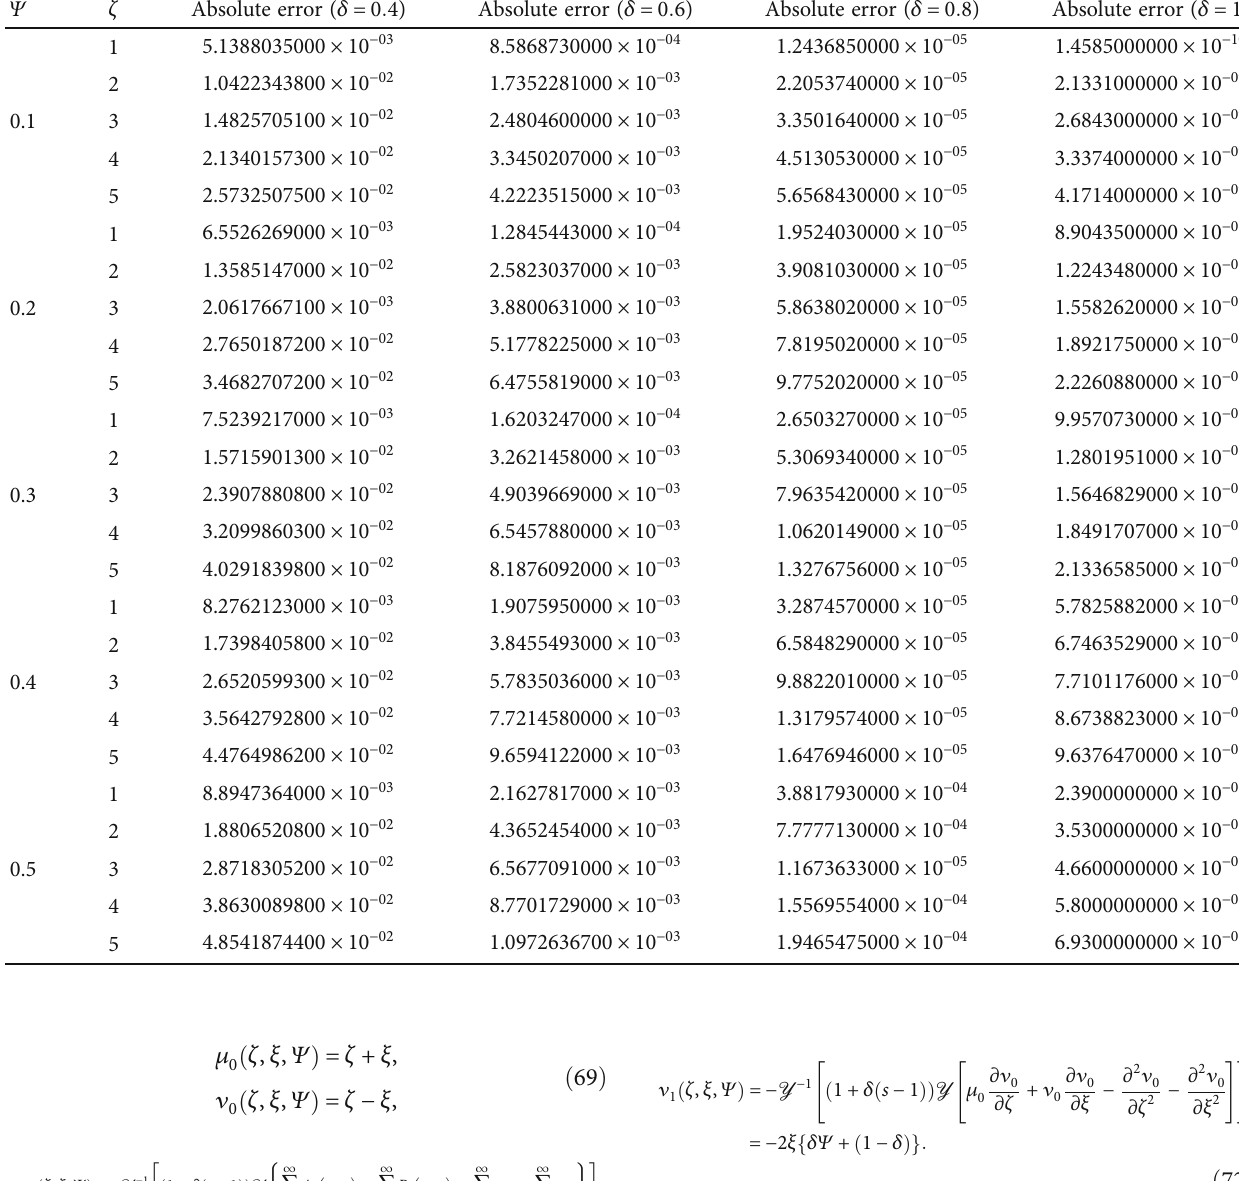
Table 2: YDM-solutions of example 1 at μ ð ζ , Ψ Þ di ff erent fractional-order of δ